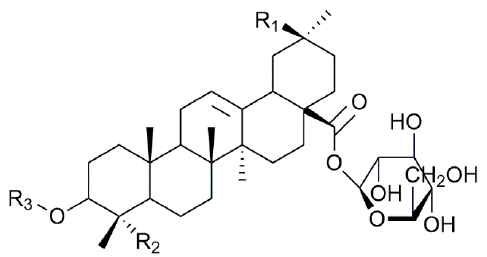
Figure 2. Schematic structure of the saponin molecules extracted from the quinoa husk. All the functions in R 1 , R 2 and R 3 are described in Table 1.